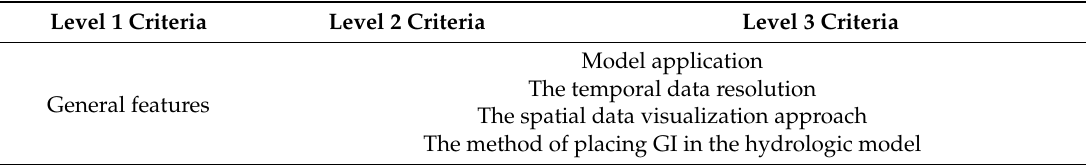
Table 2. Criteria considered for comparing the selected